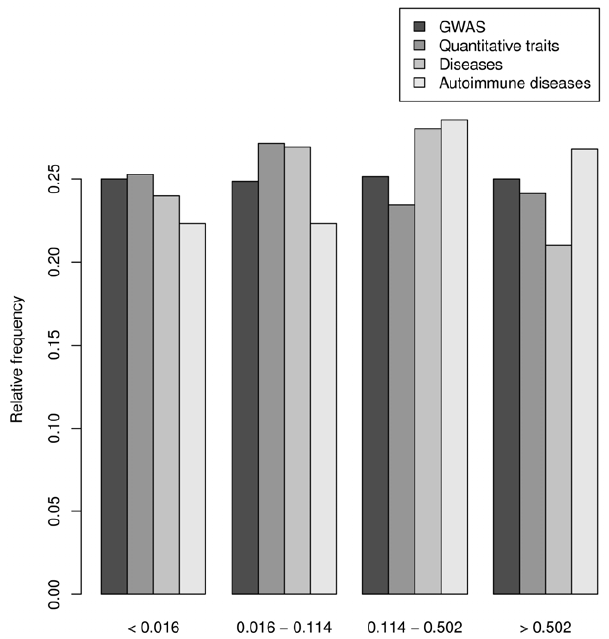
Figure 5. Frequencies of genes for different values of improvement of explained variance. Classes were defined as quartiles of distribution of improvement of explained variance for genes associated to a trait or a disease in GWASs. Bars are colored according to the association to a quantitative trait, a disease or an autoimmune disease.